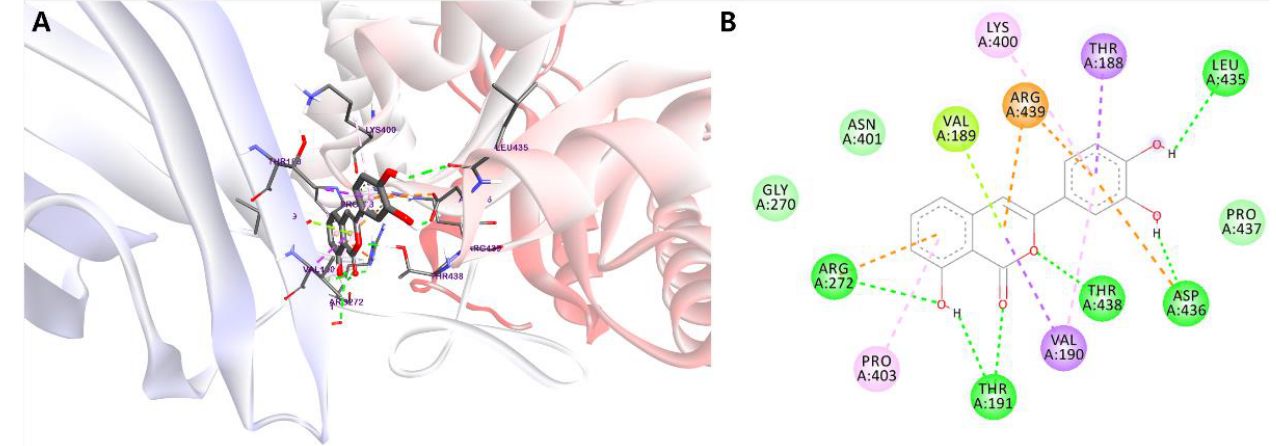
Figure 5. The 3D docking poses ( A ) and 2D interaction diagrams ( B ) of β -glucuronidase inhibition mediated by compound 1 . Green: hydrogen bonds, violet and pink: hydrophobic, orange: electrostatic, and light green: van der Waals interactions. Table 2. Docking energies and binding site interactions of compound 1 with the β -glucuronidase enzyme.